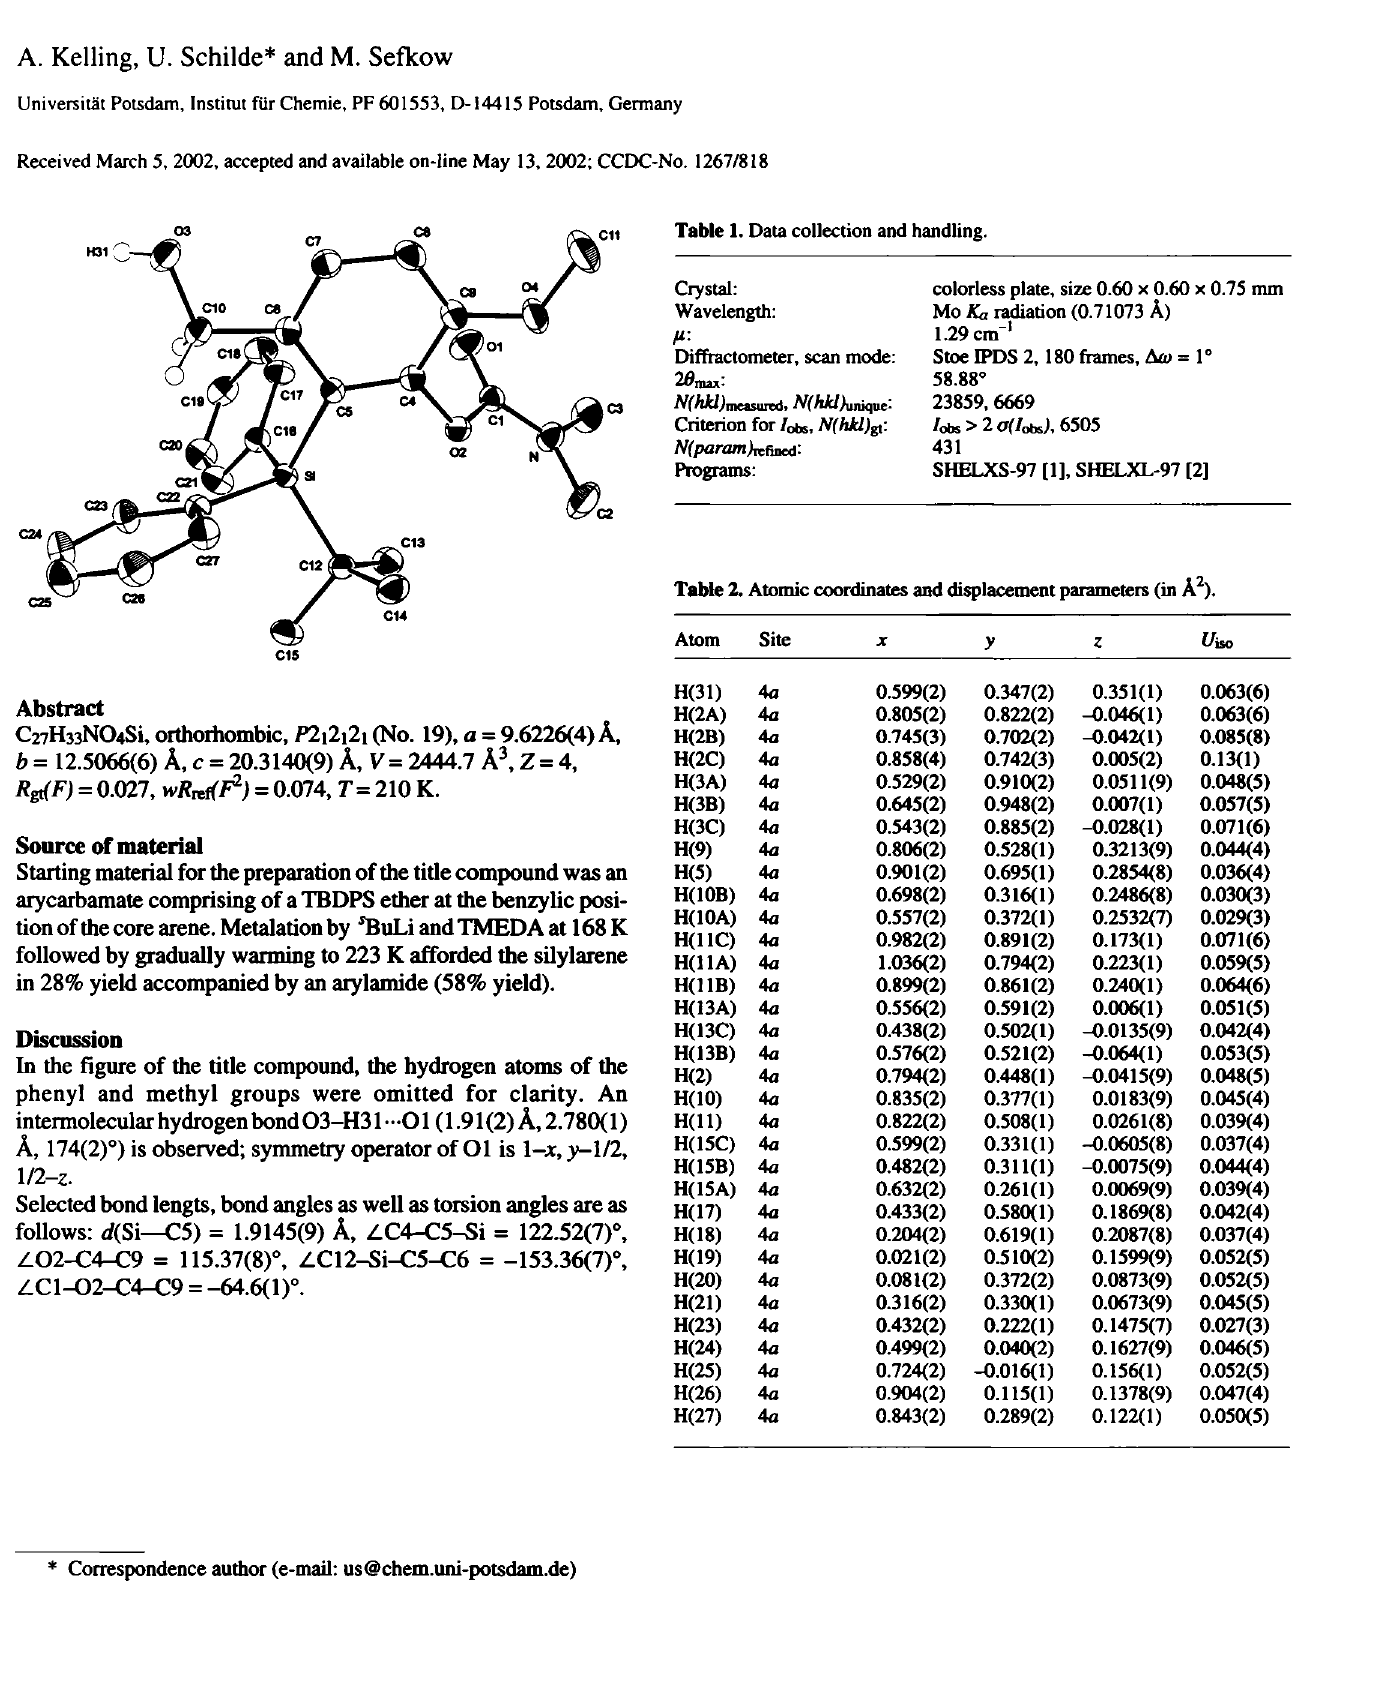
Table 1. Data collection and handling.